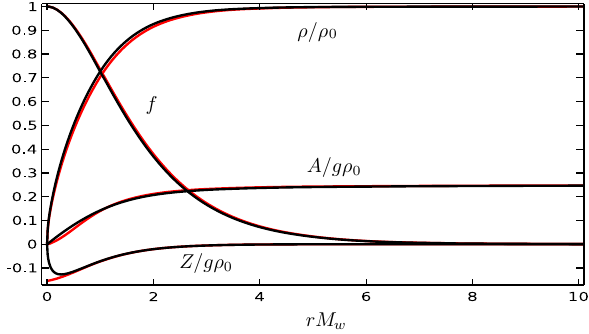
Fig. 5 The finite energy dyon solution (the red curves) regularized by the real electromagnetic permittivity ¯ (cid:14) 1 = (ρ/ρ 0 ) 6 with the W boson, Z boson, and Higgs field dressing. For comparison we plot the finite energy dyon solution regularized by the hypercharge renormalization (shown in Fig. 2) by the black curves